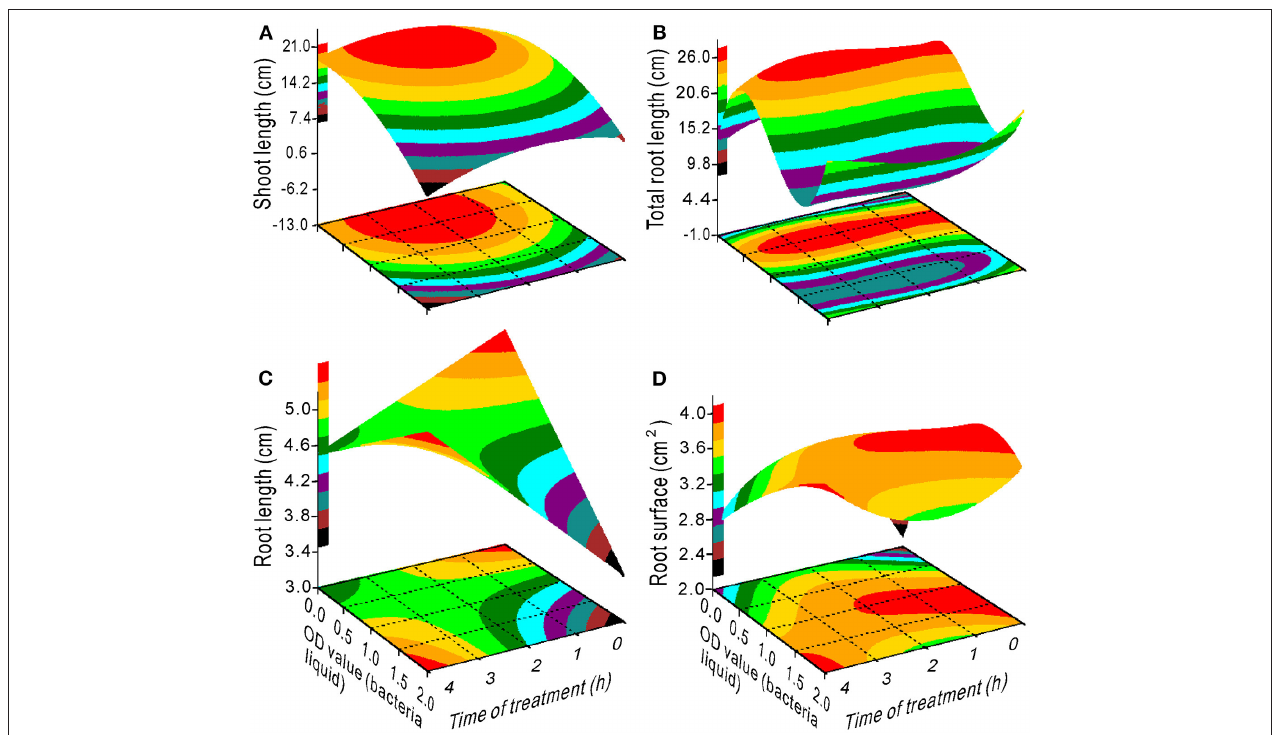
FIGURE 5 | Response surface plots showing the interaction between bacterial liquid and treatment time on shoot length (A) , total root length (B) , root length (C) , and root surface (D)